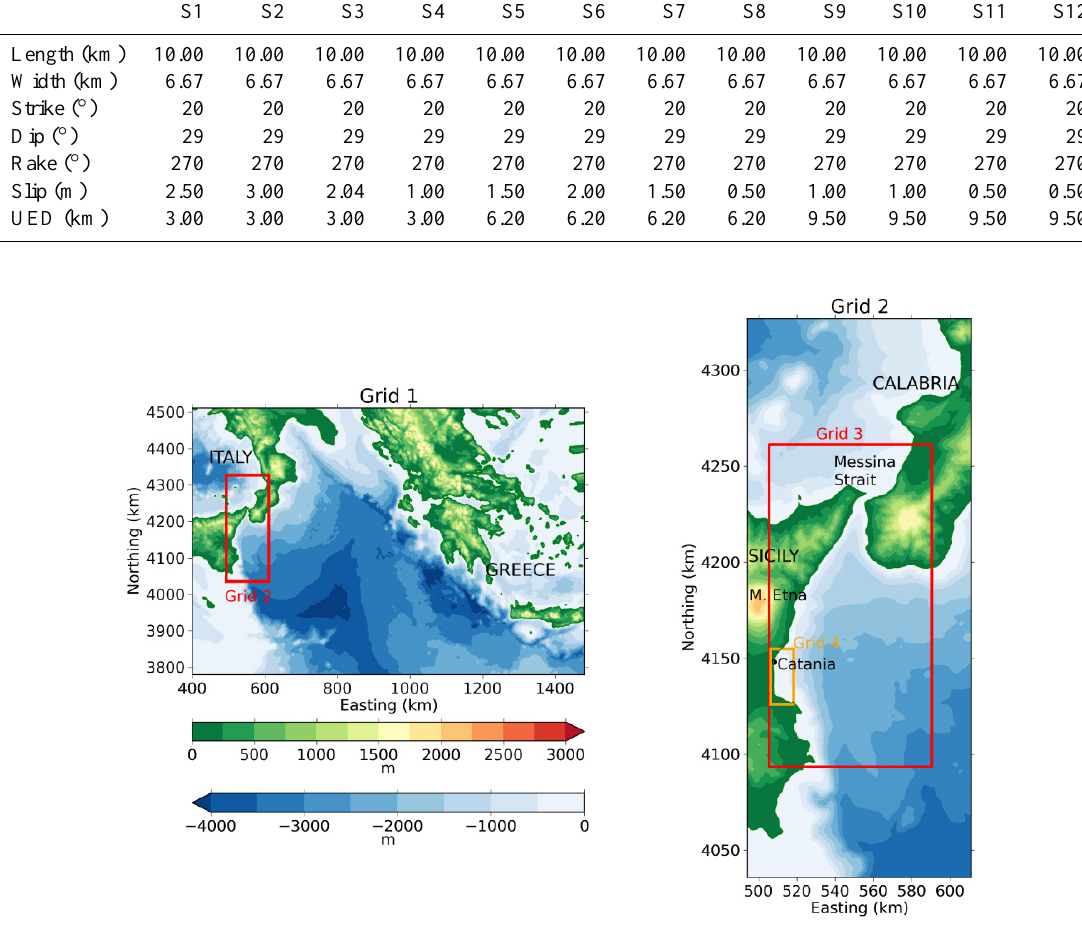
Fig. 4. Geometry and nesting of the computational grids (grid 1 to grid 4) used to perform the tsunami simulations. The grid resolutions are: 3km in grid 1, 1km in grid 2, 200m in grid 3, and 40m in grid